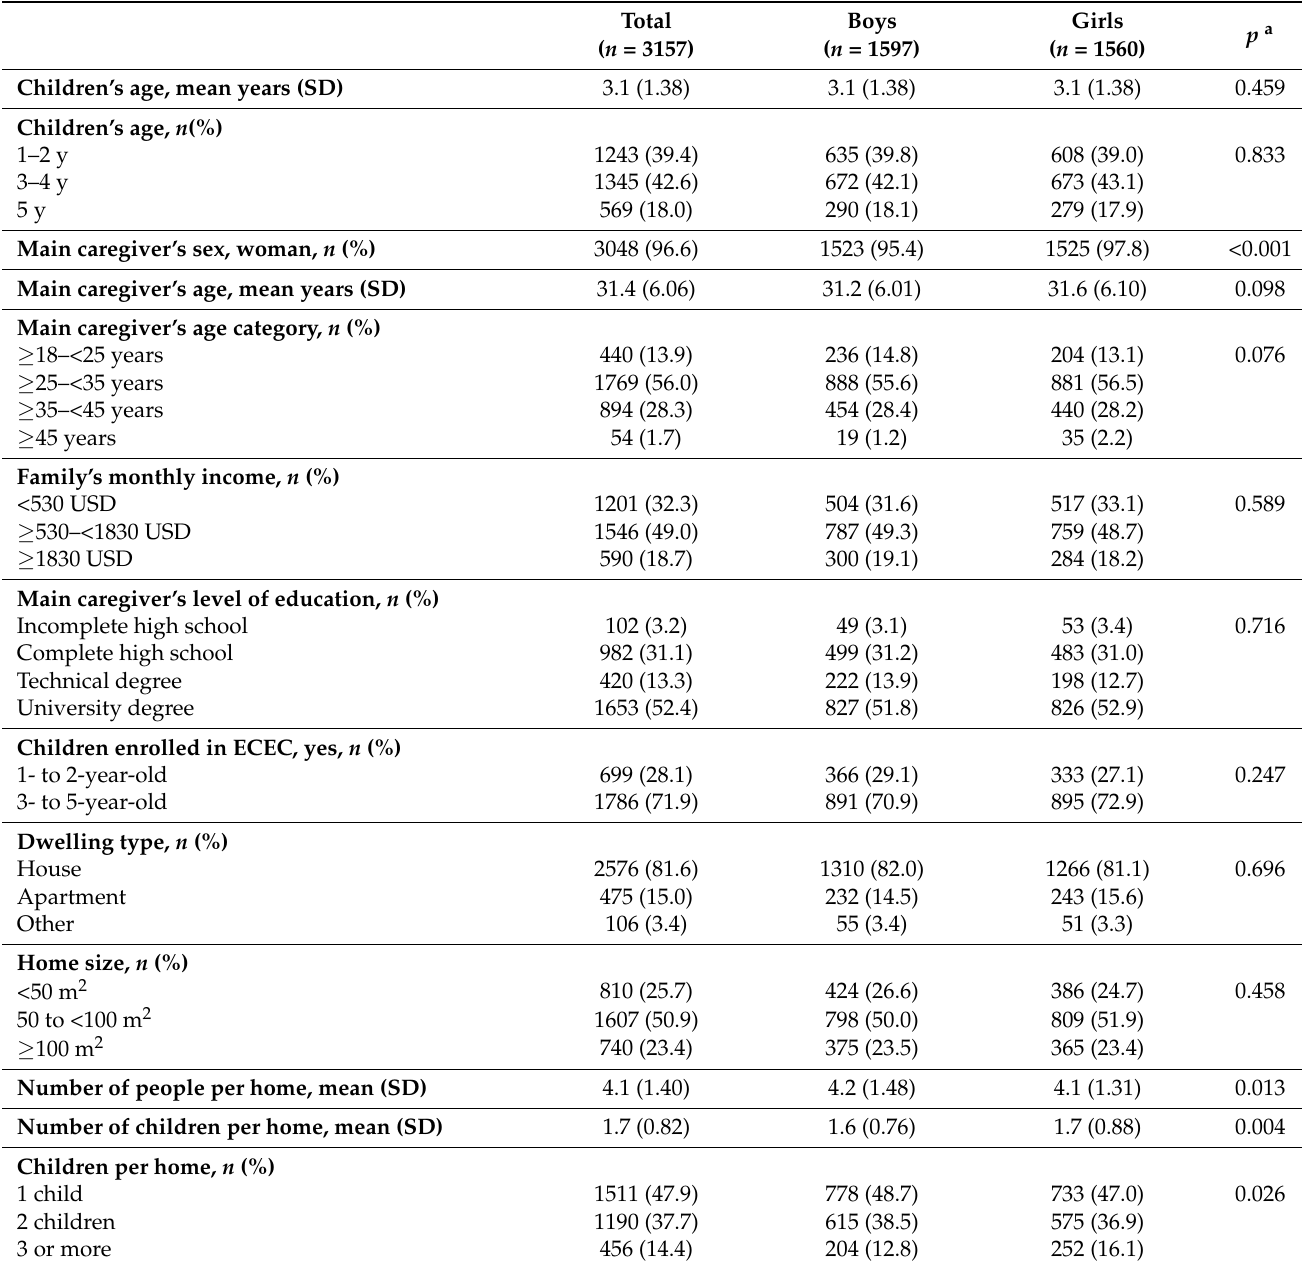
Table 1. Sample characteristics. Total ( n = 3157)